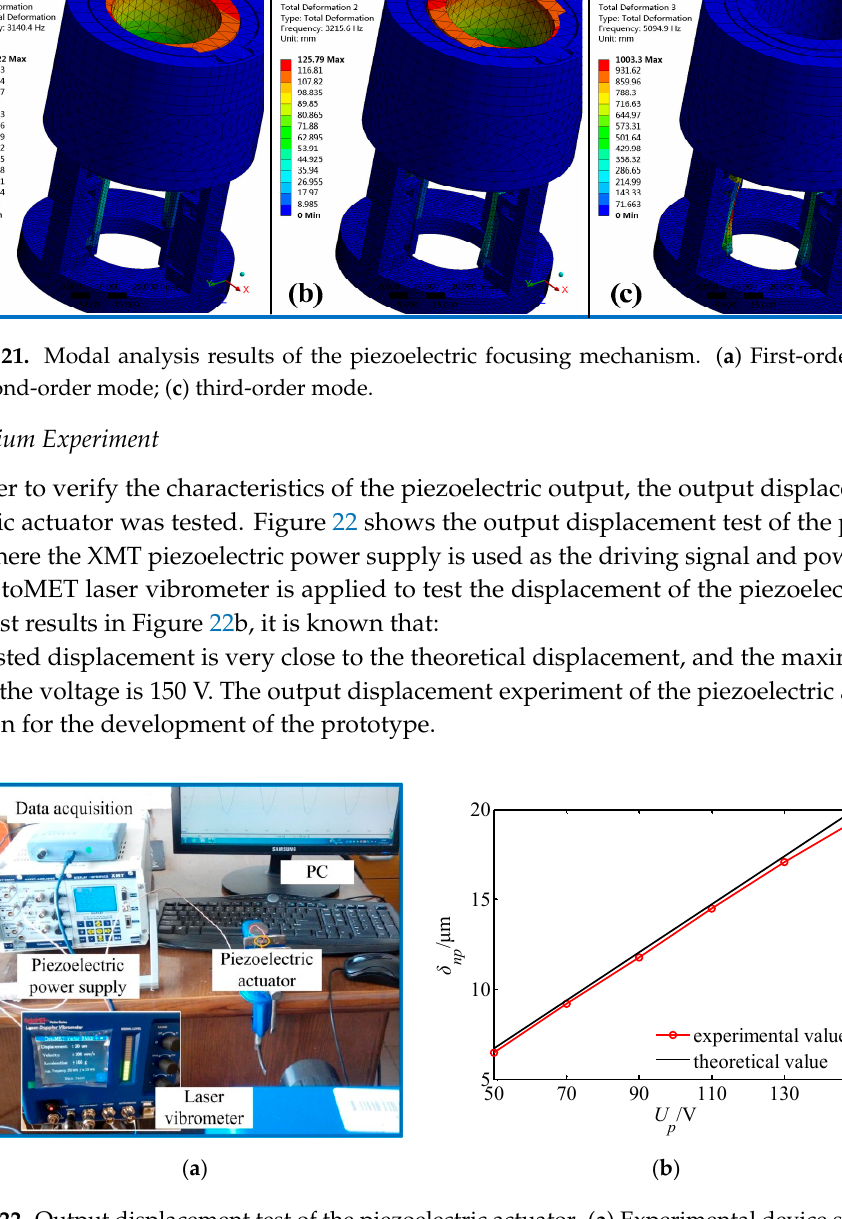
Figure 22. Output displacement test of the piezoelectric actuator. ( a ) Experimental device structure; ( b ) test results.